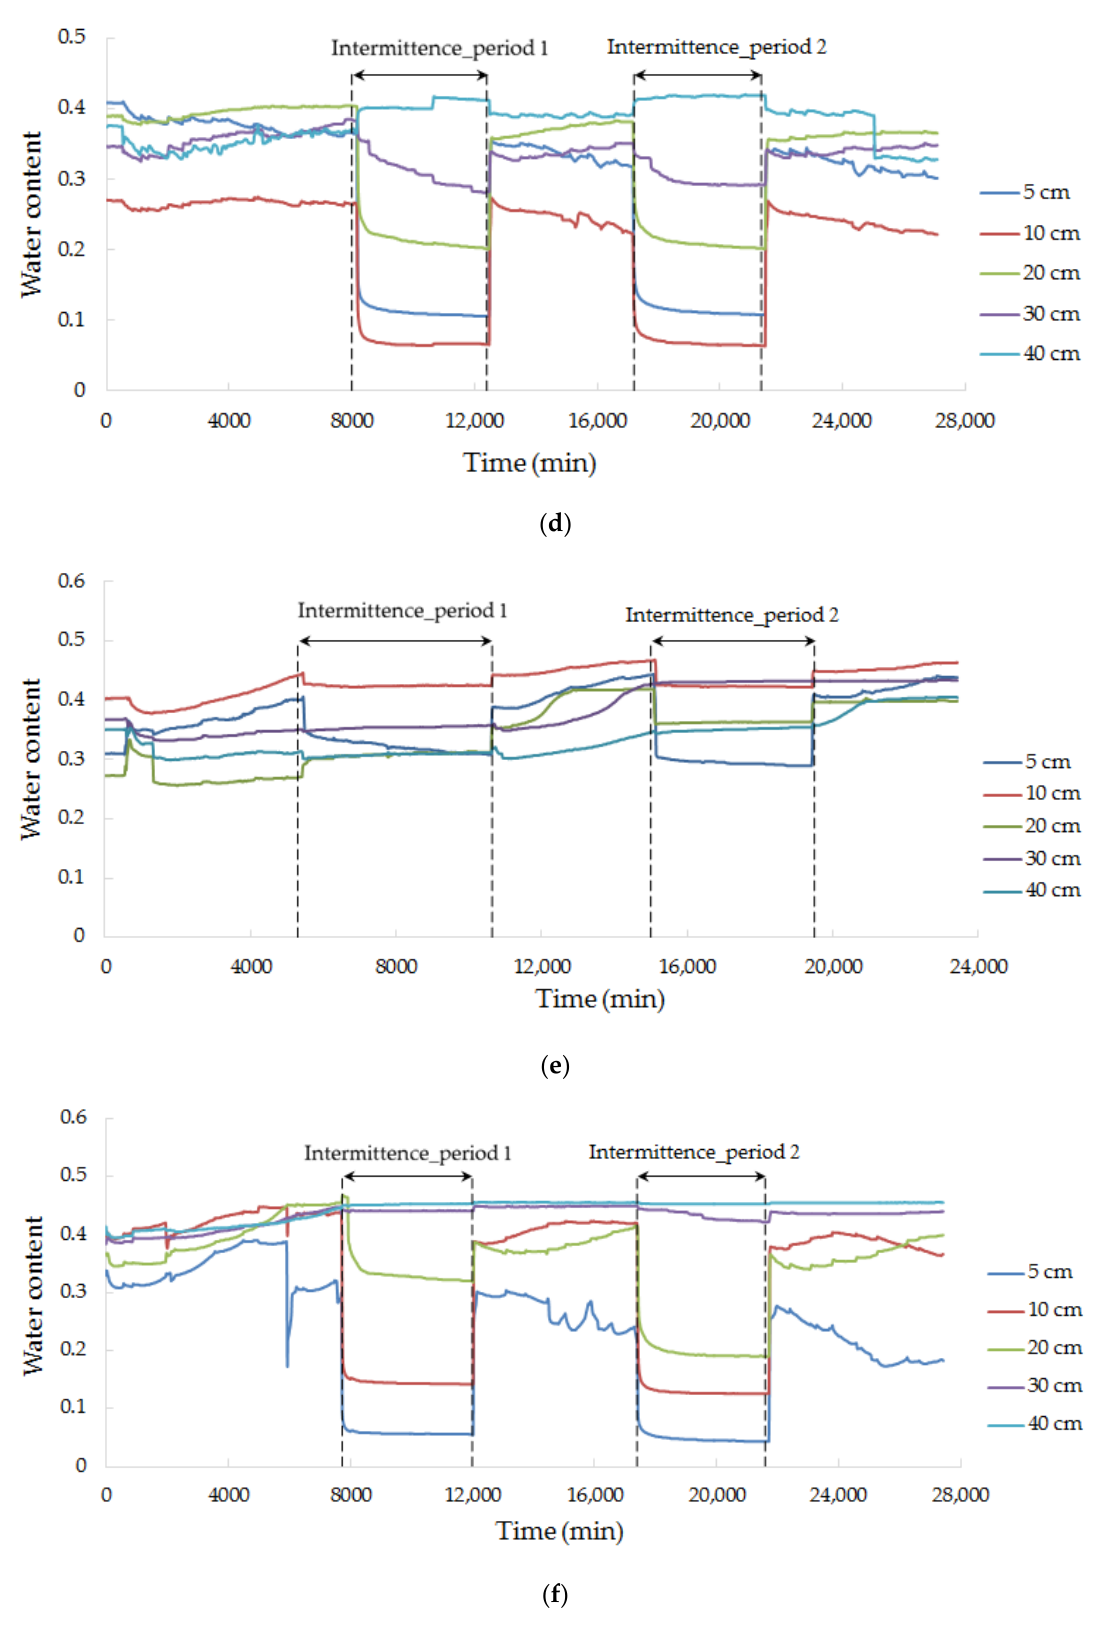
Figure 5. Water content change with time. ( a ) E1 (Fe + fine sand); ( b ) E2 (Fe + medium sand); ( c ) E3 (Zn + fine sand); ( d ) E4 (Zn + medium sand); ( e ) E5 (Pb + fine sand); ( f ) E6 (Pb + medium sand).